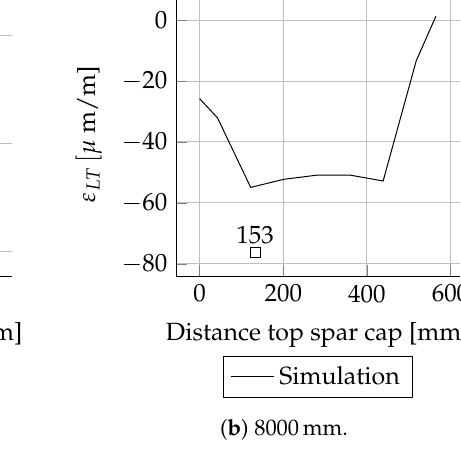
Figure A27. Cont